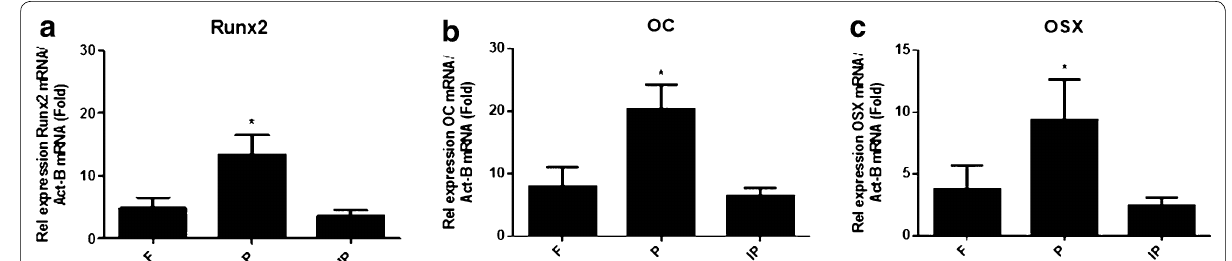
Fig. 3 TaqMan analysis of osteoblast markers: Runx2, OC and OSX expression in calvariae of C57BL/KalwRiJHsD mice. RNA was extracted with cDNA synthesized from frontal (F), parietal (P) and interparietal (IP) bones. The relative expression of osteoblast marker genes was adjusted to the relative expression of a housekeeping gene, β‑actin. Data showed that there was a significant increase in the relative expression levels of Runx2 ( a ), OC ( b ) and OSX ( c ) in parietal bone compared to frontal and interparietal bones